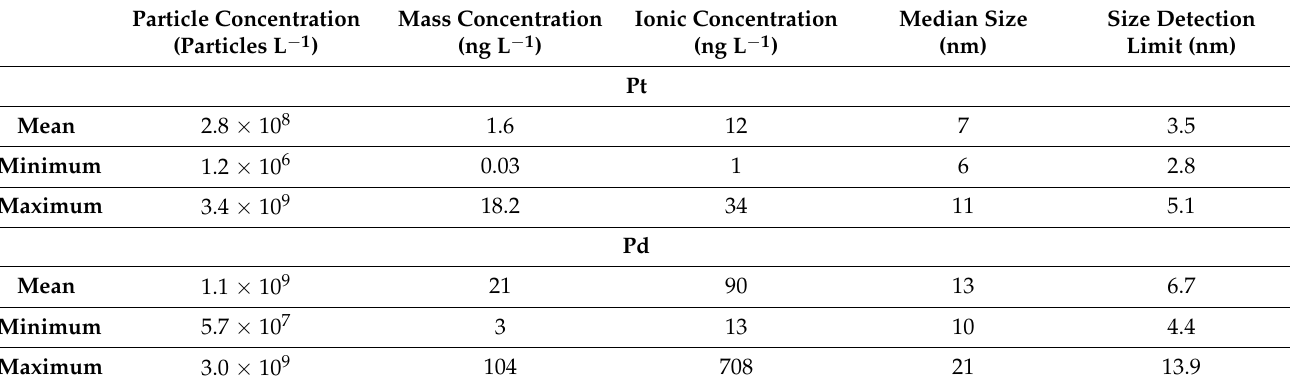
Table 4. Concentrations of nanoparticulate and dissolved species of Pt and Pd in clay fractions of road dust as obtained by